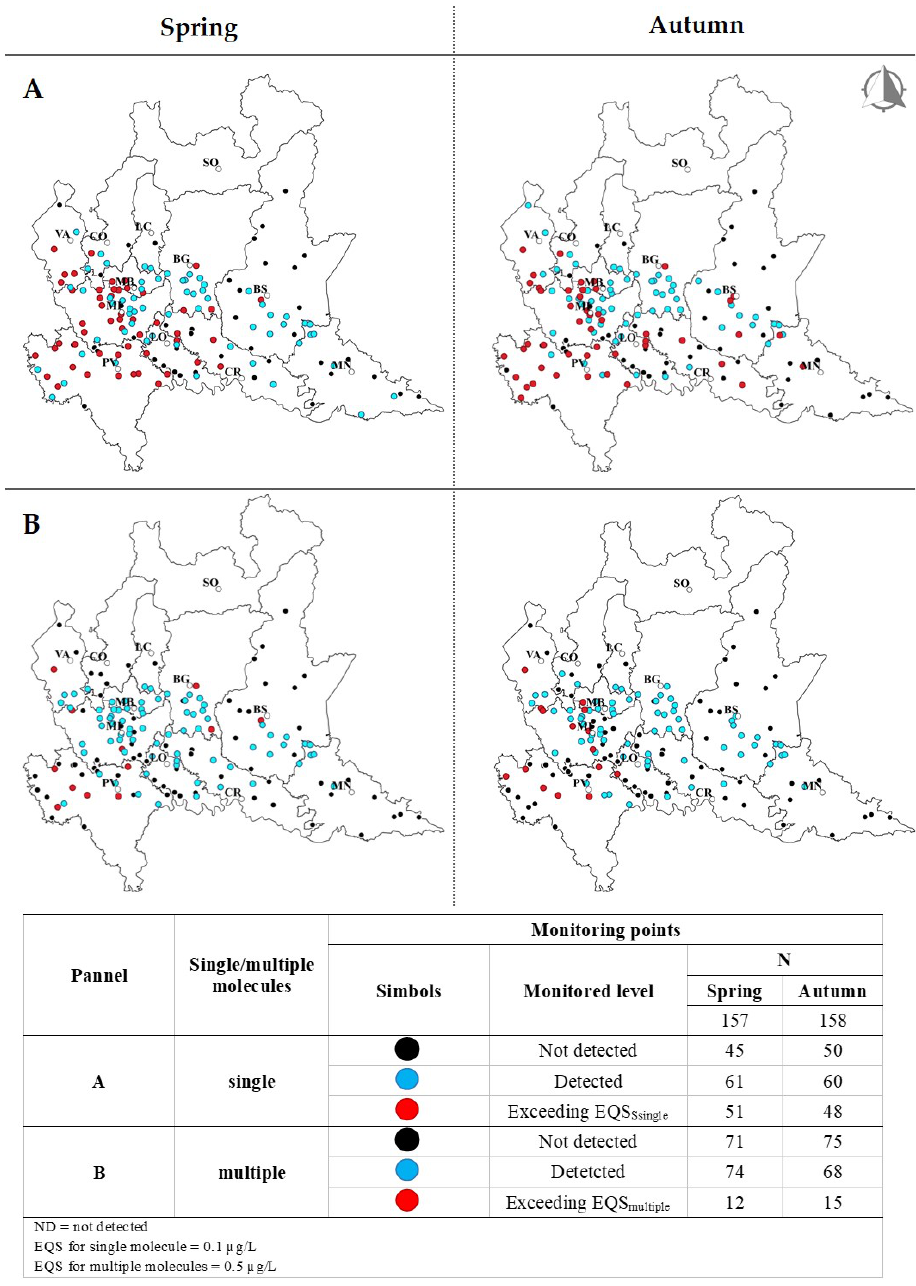
Figure 1. Maps of Lombardy, with the 12 provinces and their capitals (abbreviation). The monitoring points for groundwater are shown as dots. In panel ( A , B ): black dots = monitoring points where molecules were undetected. In panel ( A ): blue dots = points where at least one molecule was detected; red dots = points where one molecule exceeded the ESQ single . In panel ( B ): blue dots = points where two or more molecules were detected; red dots = points where two or more molecules exceeded the ESQ multiple . Results for the spring and the autumn campaign are shown.